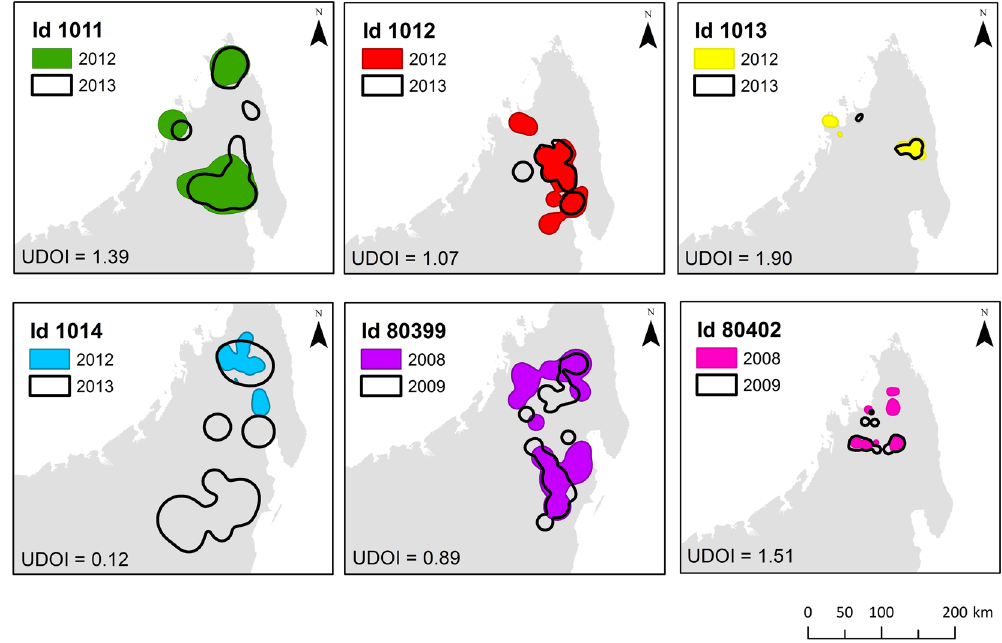
Figure 1. Strong winter site-fidelity for 6 Eleonora’s falcons as indicated by the overlap of their home ranges in consecutive wintering events and the corresponding value of the Utilization Distribution Overlap Index. Map was created with ArcGIS v10.1 (www.arcgis.com).